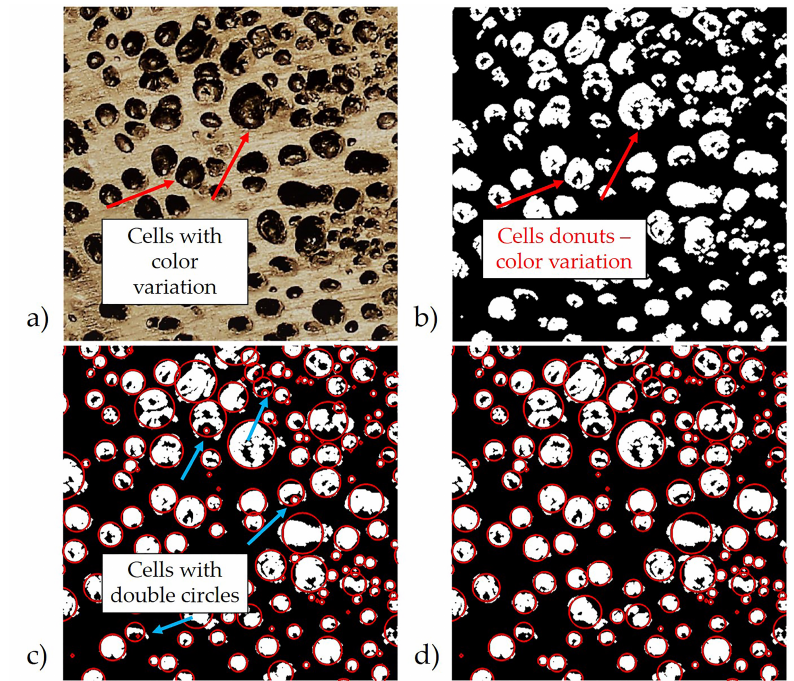
Figure 3. Image processing false positives. ( a ) Image with a yellow tint showing color contrasts within cells. ( b ) Pixel formation of cell donuts based on color contrast. ( c ) Cells with double circles. ( d ) Filtering the image of double